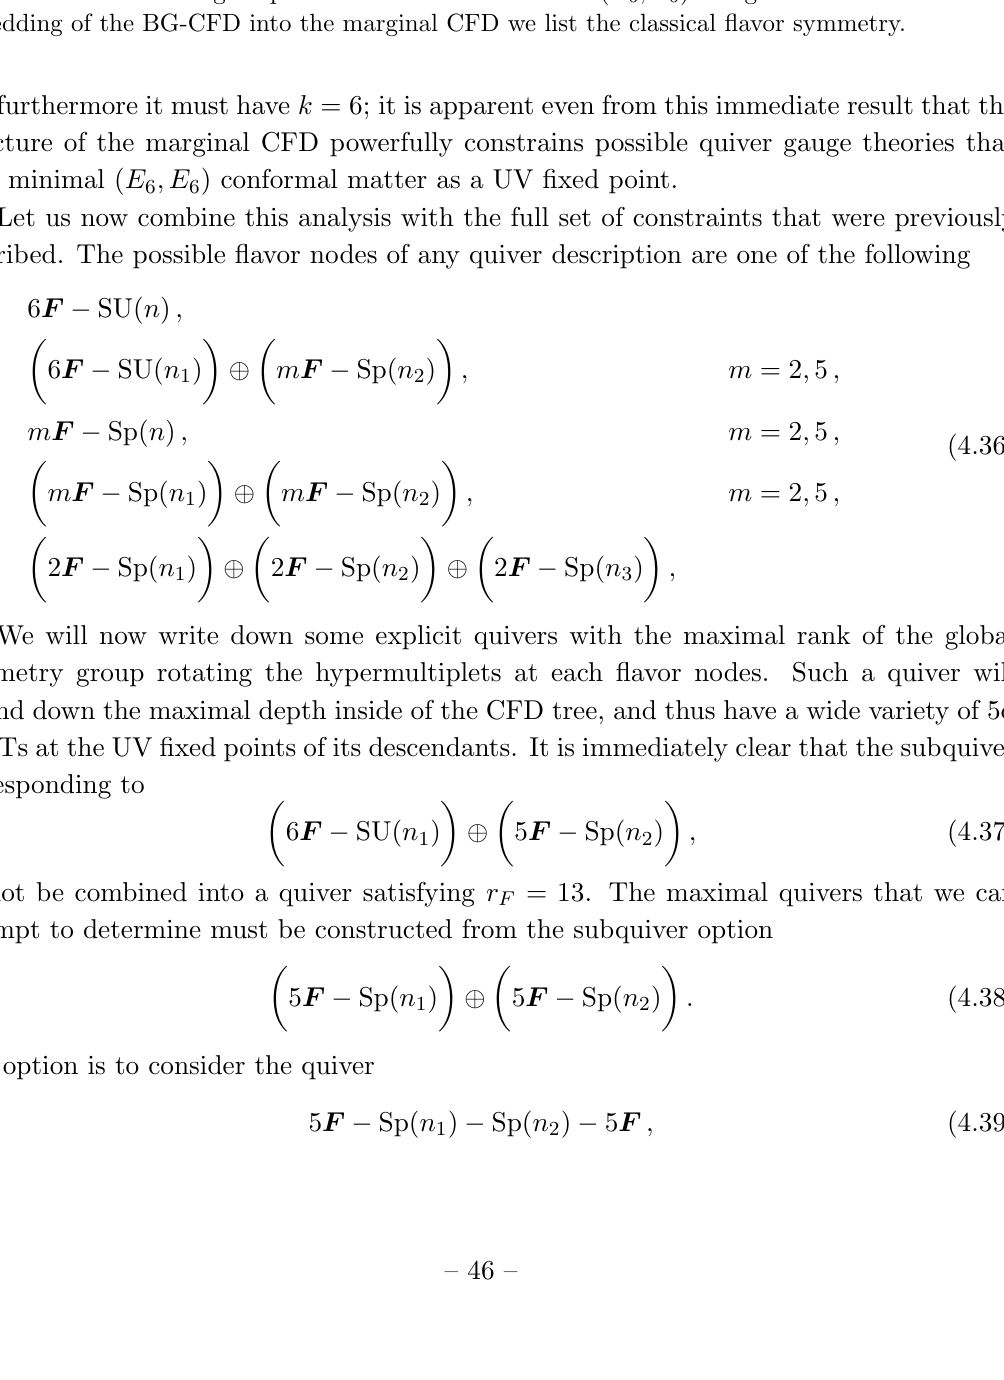
Figure 15. Embedding of potential BG-CFDs into the ( E 6 ; E 6 ) marginal CFD. Below